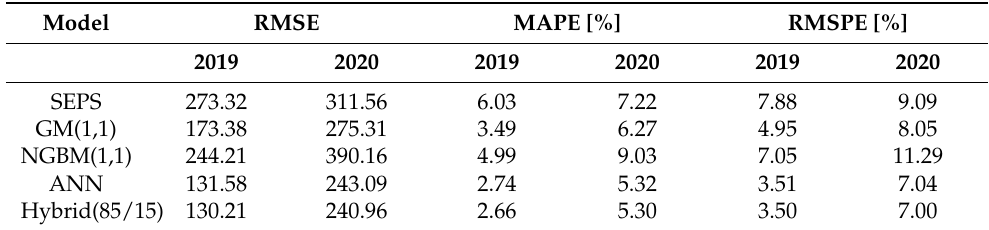
Table 1. Prediction performance comparison. Model